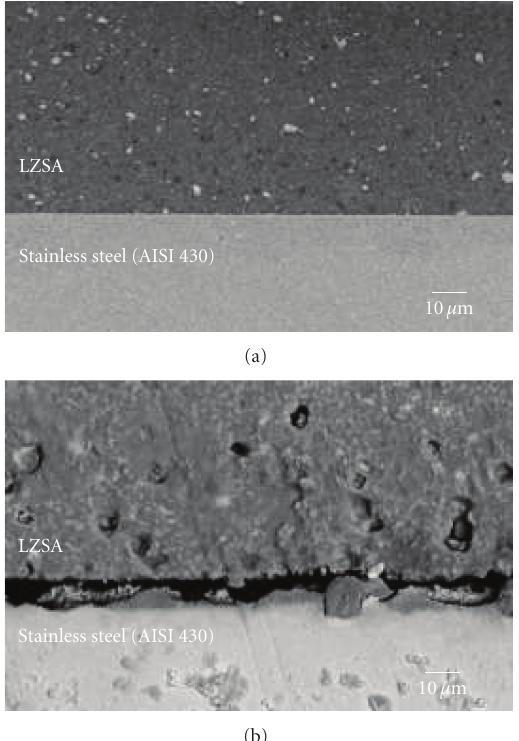
Figure 8: Comparison of interface of cofired LZSA-steel bi-layer: 800 ◦ C (a) and 900 ◦ C